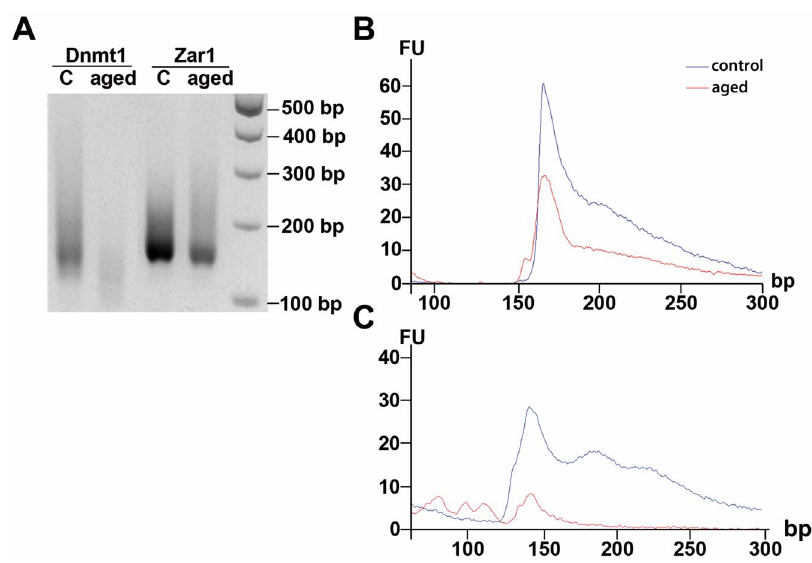
Figure 5. Quantification of poly(A) tail length for Dnmt1 and Zar1 by ePAT. 24 h postovulatory-aged, in vivo-grown oocytes were analyzed by extension poly(A) test (ePAT). A) Gel electrophoresis of the product shows a decrease of poly(A) tail length for Dnmt1 in aged oocytes compared to controls, whereas poly(A) tail length of Zar1 remains widely stable. These results were quantified by capillary electrophoresis for Zar1 (B) and Dnmt1 (C). Indicated is the fluorescence intensity (FU) of amplicon lengths (in base pairs) for aged oocytes (red line) and controls (blue